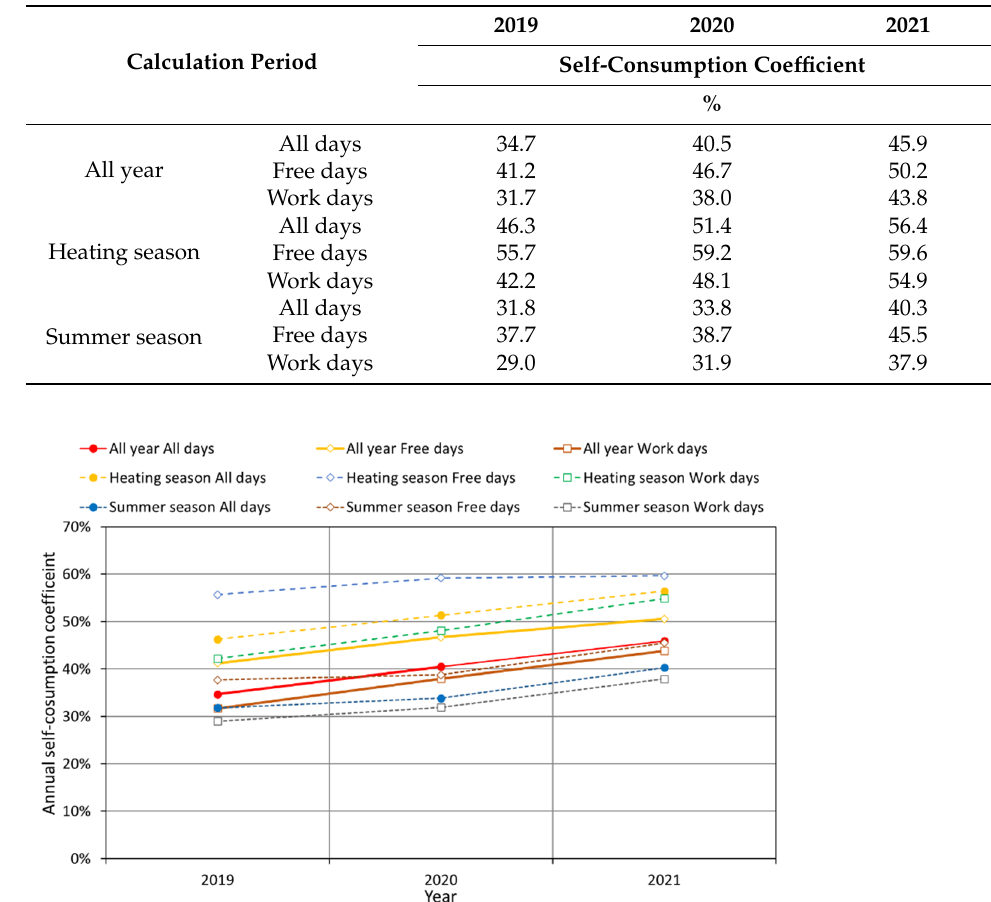
Figure 10. The annual self-consumption in 2019, 2020 and 2021. Table 9. Energy cost in tariff G13 before and after introducing the HEMS in 2019 and the ESSS in 2021.